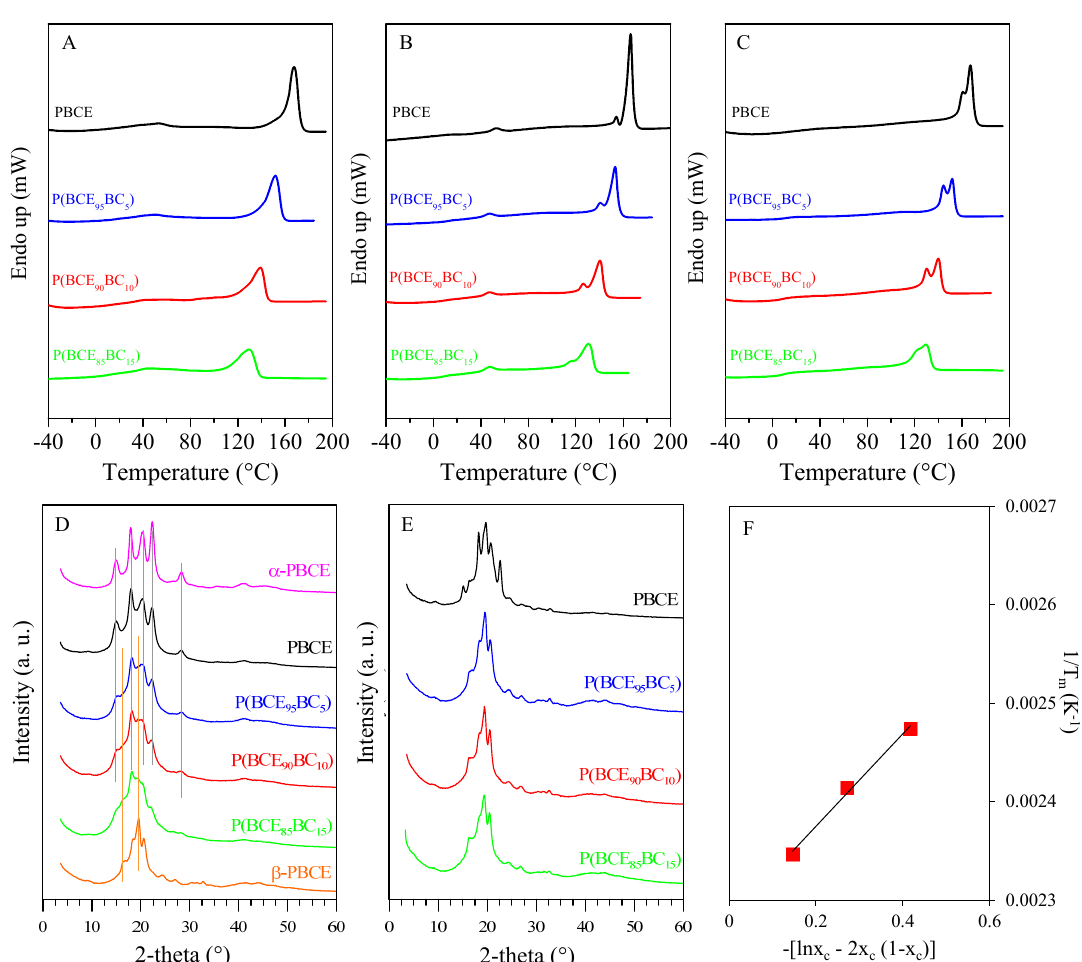
Figure 4 . Calorimetric curves (heating rate: 20 °C/min) and diffraction profiles (WAXS) of the PBCE and related P(BCE x BC y ) copolymers. ( A ) I scans of powders; ( B ) I scans of films; ( C ) II scans after rapid cooling from the melt; ( D ) WAXS profiles of powders (for PBCE, the diffractograms corresponding to α -PBCE and β -PBCE crystal lattices, previously obtained by different treatment are also shown for comparison; vertical lines are eye guides); ( E ) WAXS profiles of films; ( F ) 1/T m vs. − [lnx c − 2x c (1 − x c )] for the P(BCE x BC y ) copolymers. The line represents the theoretical trend according to the Baur equation.